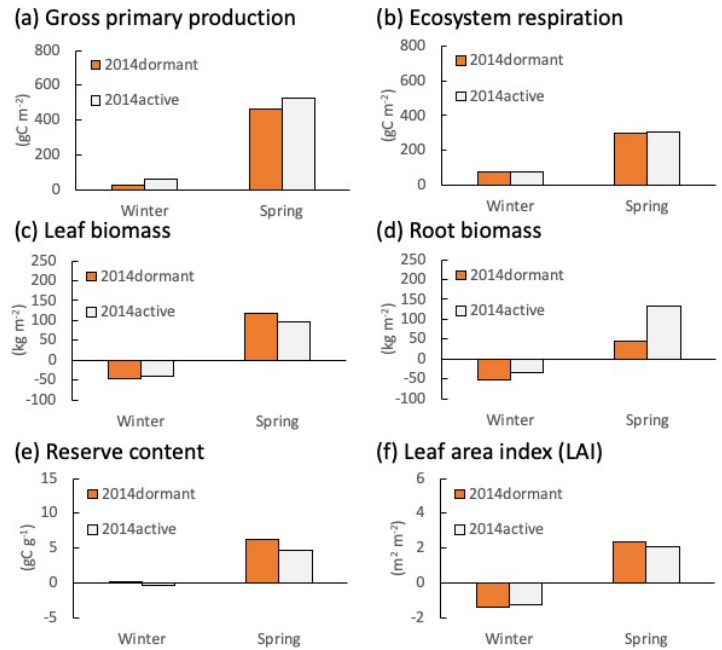
Figure 6. Changes in calculated (a) gross primary production (GPP), (b) ecosystem respiration, (c) live leaf and (d) root biomasses, (e) re- serve content, and (f) leaf area index (LAI) at Graswang during the winter (from December to February) and spring (from March to May) in 2014 in active (grey bars) and dormant cases (orange